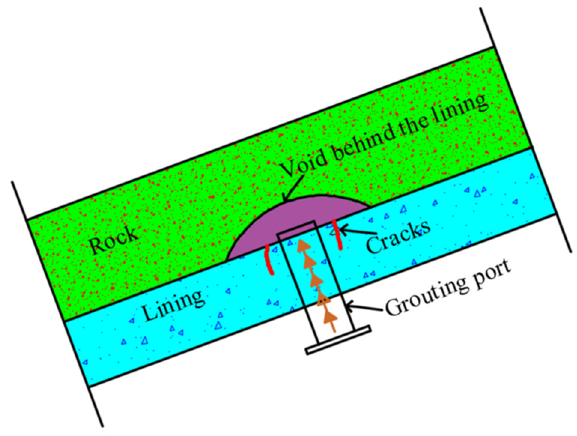
Figure 13. Grouting of a void behind the lining.